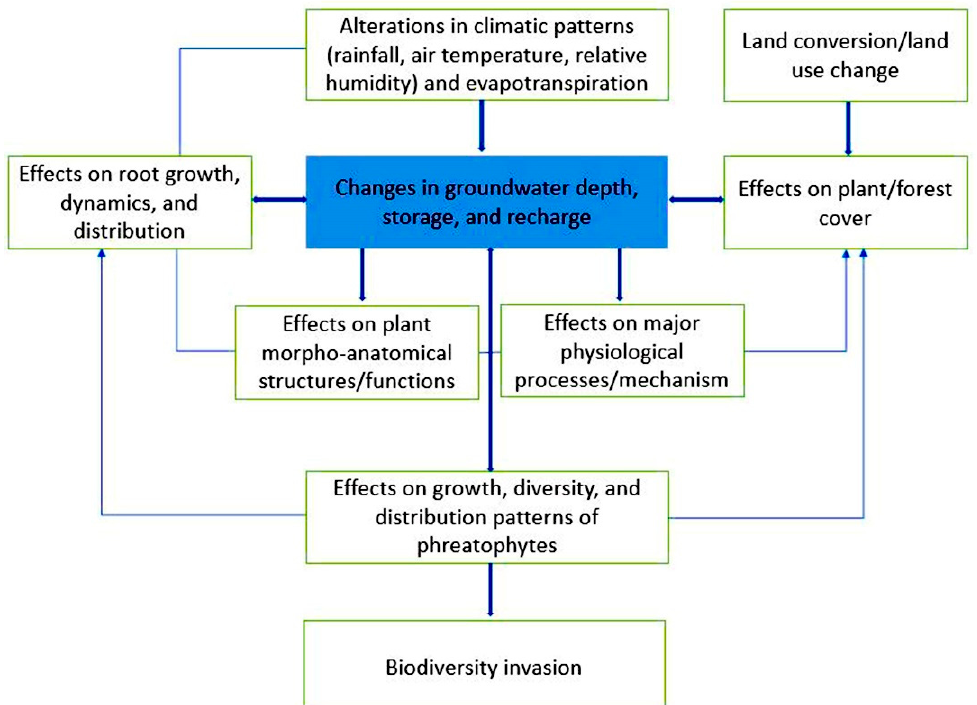
Figure 5. Synergistic effects of changes in groundwater characteristics on phreatophytic vegetation.